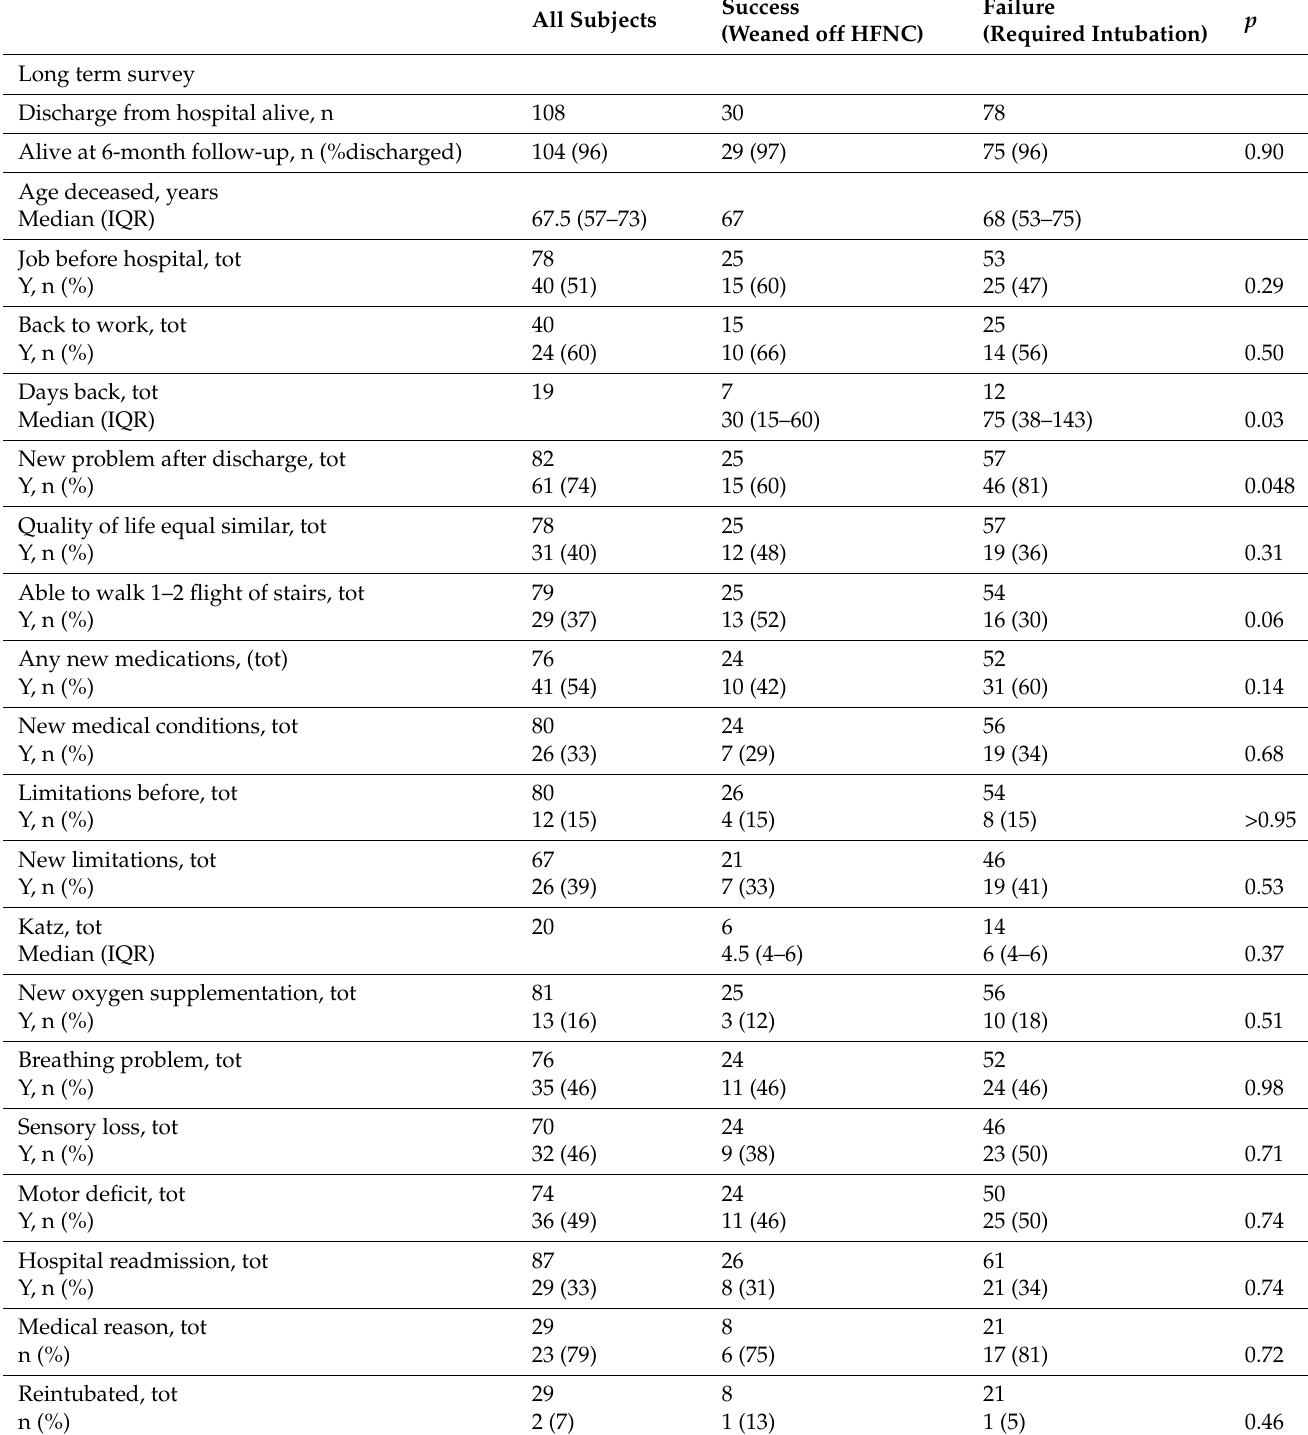
Table 1. Follow-up at 6 months. HFNC = High flow nasal